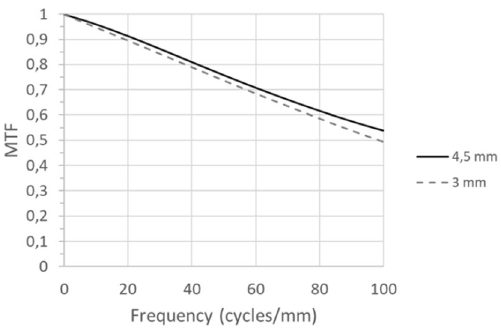
Figure 1. Modulation Transfer Function (MTF) up to 100 cycles/mm of the ICL for the pupil sizes of 3 mm and 4.5